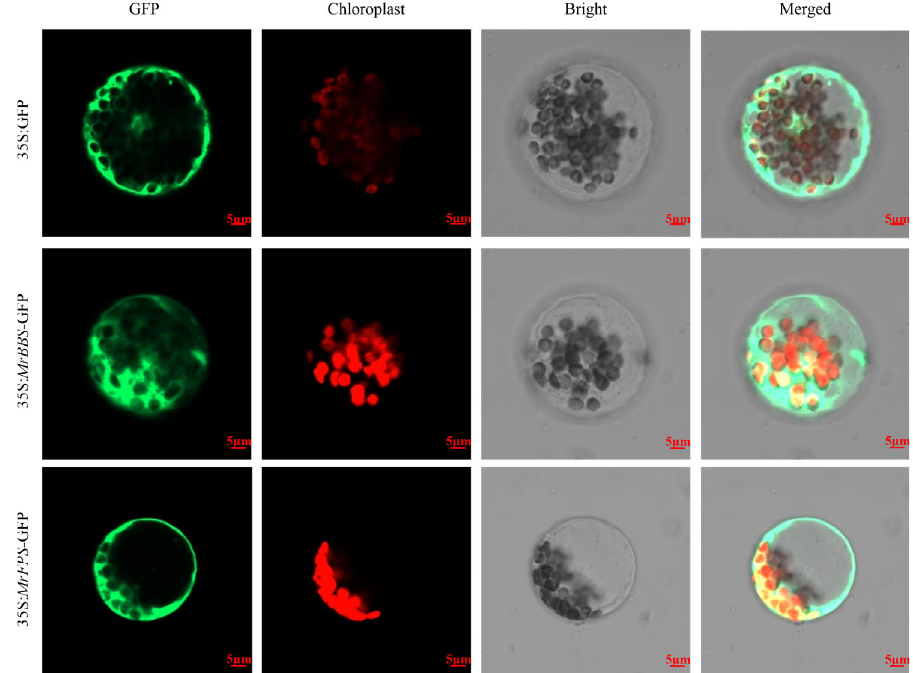
Figure 5. Subcellular localization of MrFPS and MrBBS in protoplasts of Arabidopsis thaliana. All samples were visualized using confocal microscopy. GFP means GFP fluorescence; Chlorophyll means Chlorophyll fluorescence; Bright means Light field; Merged means superposition of fluorescence. Control vector (35S: GFP) and recombinant vectors (35S: MrFPS ‐ GFP and 35S: MrBBS ‐ GFP) were expressed in protoplasts of Arabidopsis thaliana .